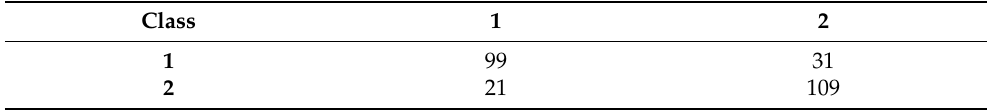
Table 11. SVM confusion